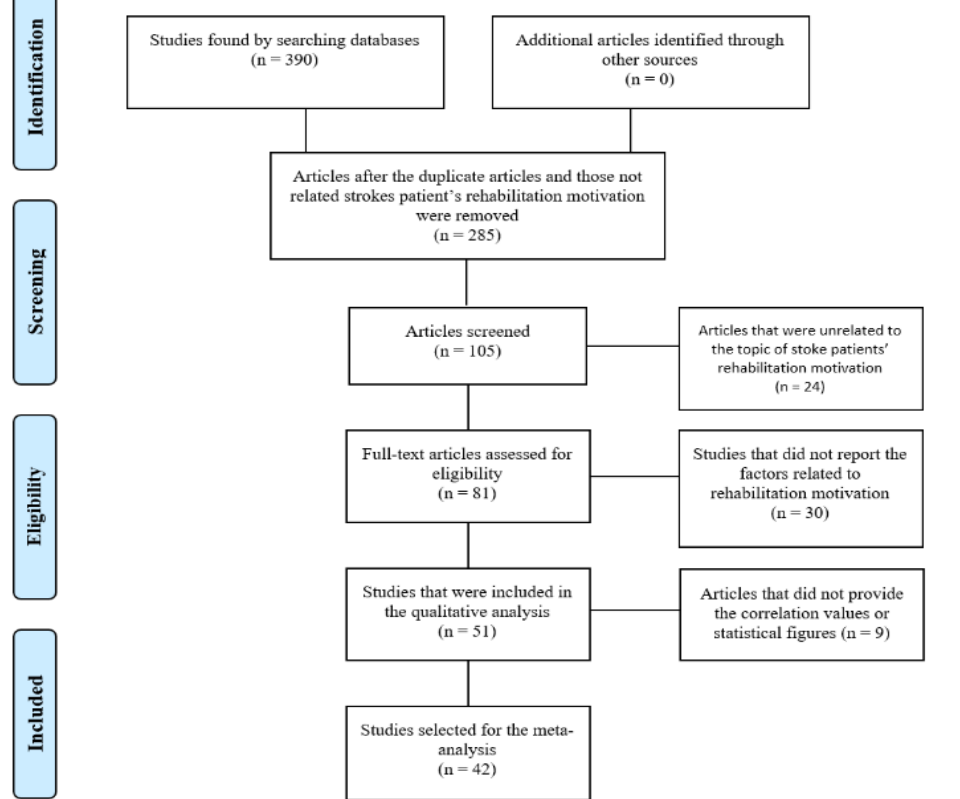
Figure 1. PRISMA Flow diagram.